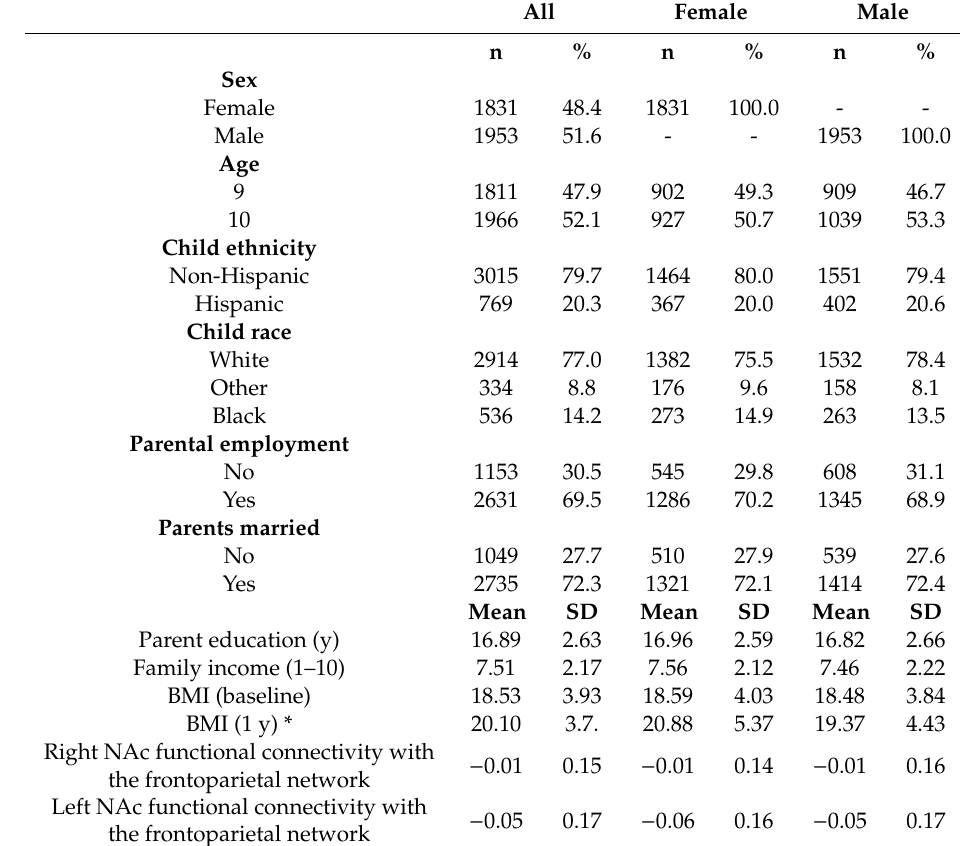
Table 1. Data overall ( n =